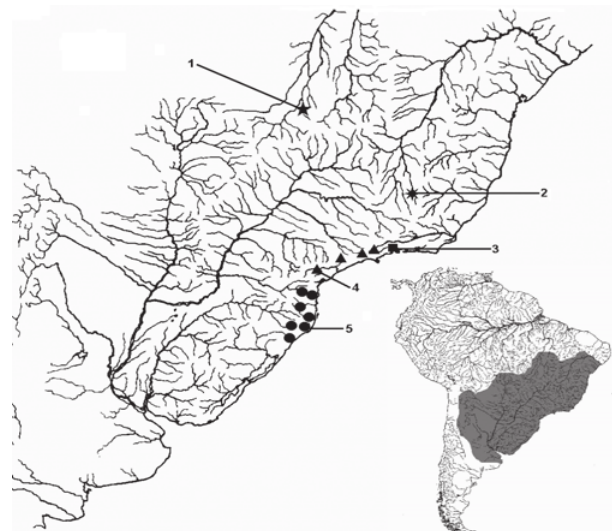
leptokeras + P . aspilos + P . tupinamba + P . elachistos + P . titthos + P . enneaktinos + P . harpagos + P . ocellatus + P . alessandrae + P . malabarbai + P . megapolos + P . Fig. 7. Collection localities of Phalloceros leticiae (five- lucenorum + P . uai + P . buckupi + P . anisophallos + P . pointed star, 1), P. uai (eight-pointed star, 2), P. anisophallos pellos + P . spiloura + P . reisi (square, 3), P. reisi (triangle, 4), and P. spiloura (circle, 5). Some symbols represent more than one lot or locality. Numbers Clade 96, Lucinda & Reis (2005). represent type localities. The inset is the range of the Mariana Pimentel, Rio Grande do Sul, Brazil, 23 May 1997, W. Bruschi Jr. & G. Vinciprova. Paratypes . BRAZIL. Rio Grande do Sul. MCP 19831, 20/4*, col- lected with the holotype. MCP 19832, 19, Mariana Pimentel, arroio da Cascata, affluent to arroio dos Ratos, at Horto Florestal Mariana